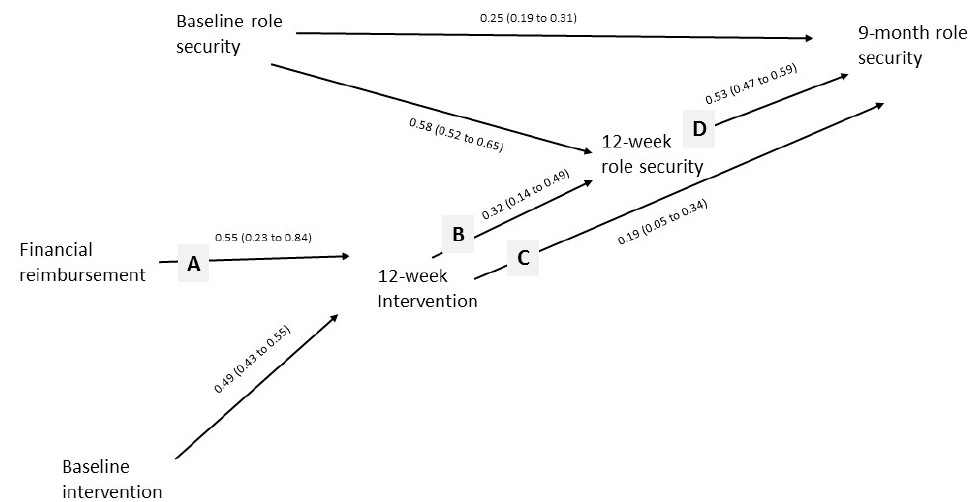
Figure 5. Unstandardized estimates (95% confidence intervals) for interrelationships between role security and financial reimbursement (estimates for impact of financial reimbursement have been doubled—see statistical methods).